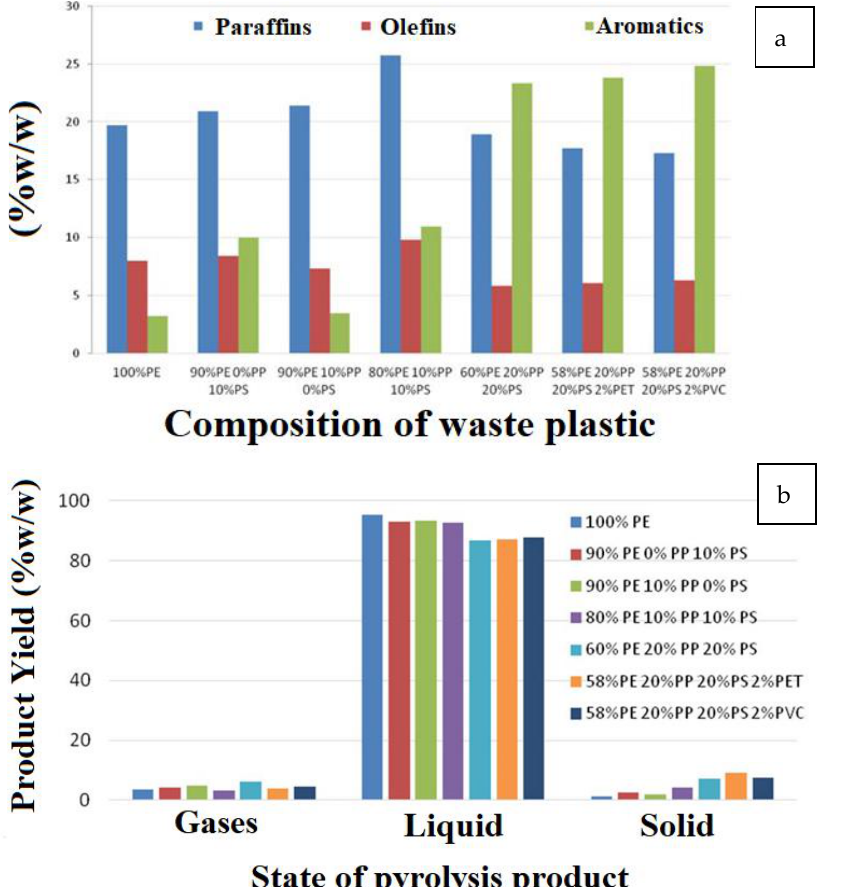
Figure 9. ( a ) Chemical composition (in weight %) and ( b ) Solid, liquid and gas (in weight %) yield of product obtained from pyrolysis of WEEE and MSW streams. Reprinted with permission from ref. [28].